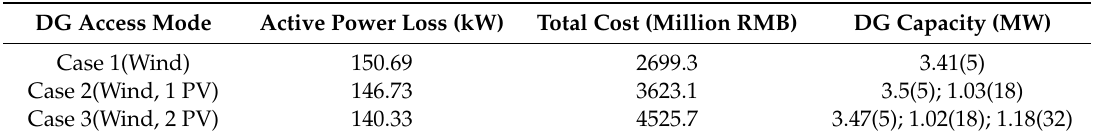
Table 2. Results of kernel extreme learning machine with electric